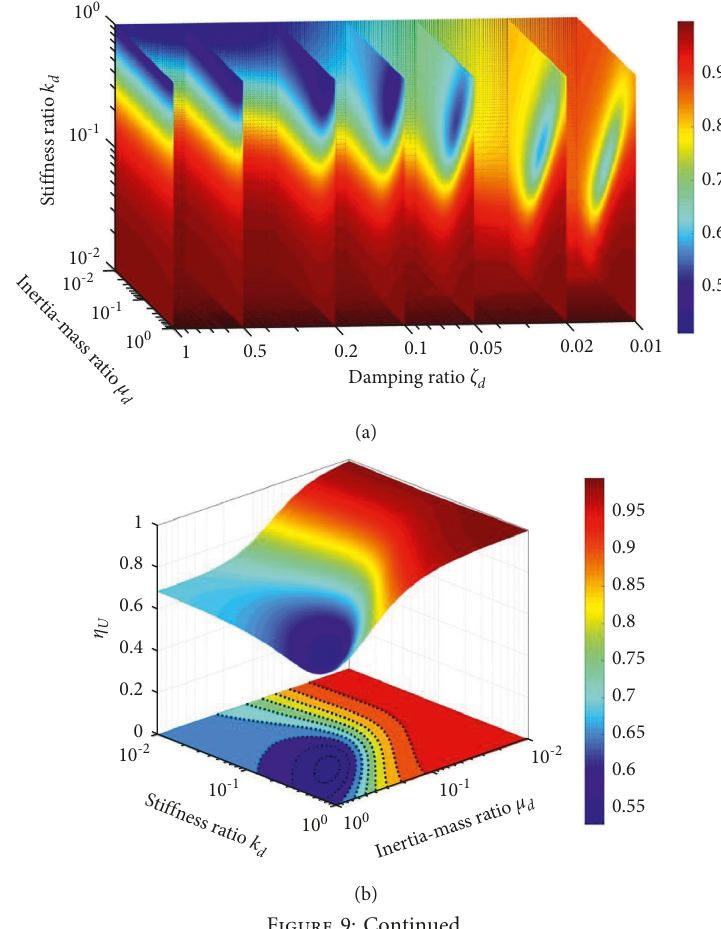
Figure 8: Mitigation ratio of displacement response: (a) changing μ factor ( κ d � 1, ζ d �